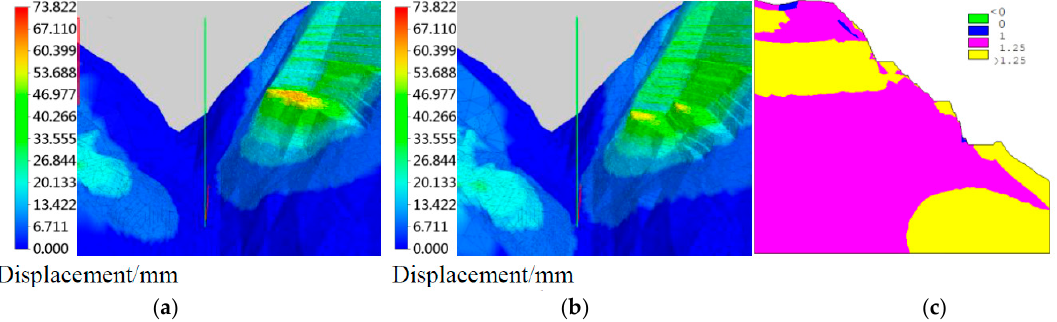
Figure 12. Numerical simulation results for real-time safety evaluation ( a ) Deformation of the slope at 4 May 2013; ( b ) Deformation of the slope at 10 September 2013; and, ( c ) Safety factor of slope section.